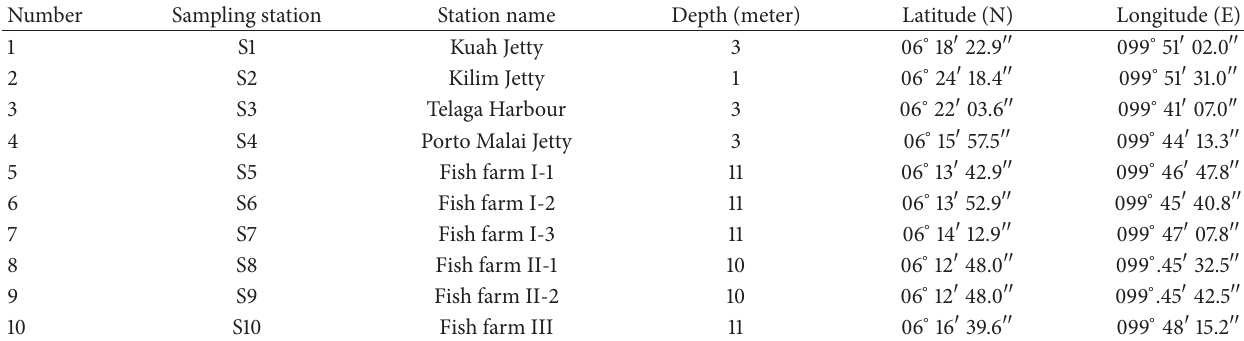
Table 1: Sampling locations and their associated water